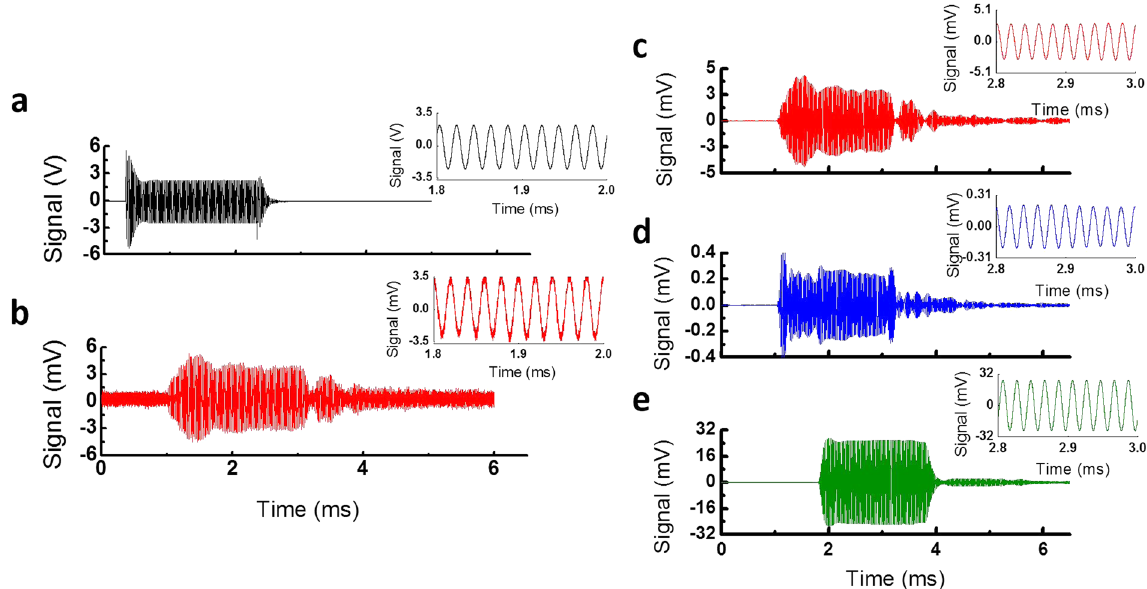
Figure 4. Temporal response of different ultrasound detectors to a 50 kHz air-coupled ultrasound transducer (AirMar AR 50). Transmit ultrasound burst of 100 cycles was generated. All data were averaged 256 times. Response data in ( c , d and e ) are post-filtered with a bandpass filter with a f 0 = 50 kHz and Δ f = 20 kHz. Insets show sinusoidal temporal signals for each detector. ( a ) Driving voltage input to the 50 kHz transmitting transducer. Sinusoidal burst output with a center frequency of 50 kHz was sent to the transducer. ( b ) Detected transmission signal from the ring resonator. ( c ) Post-filtered transmission signal from the ring resonator with a bandpass filter. ( d ) Post-filtered signal from the 800 kHz ultrasound transducer. ( e ) Post-filtered signal from the